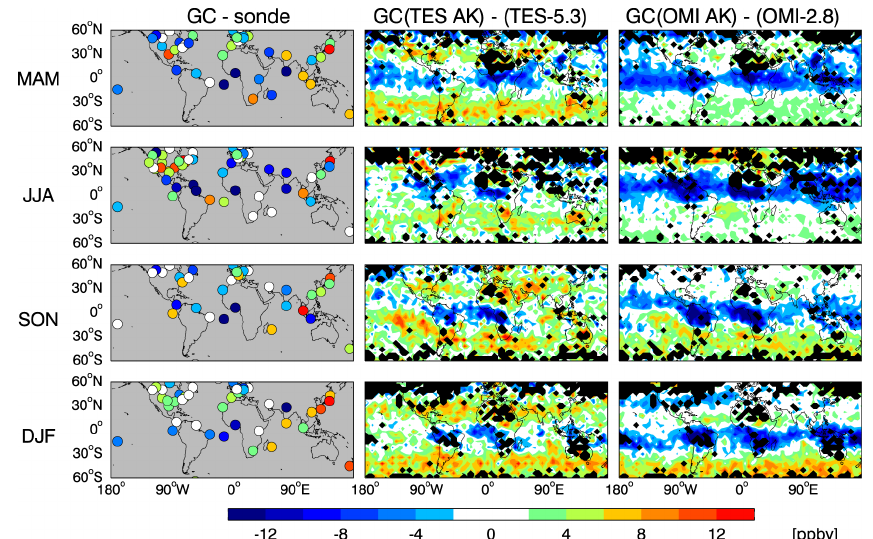
Fig. 8. Differences of simulated GEOS-Chem (GC) ozone concentrations (ppbv) at 500hPa with ozonesondes (left), TES (central), and OMI (right), averaged for the four seasons of 2006. Comparisons with TES and OMI use the GEOS-Chem profiles smoothed by the respective instrument averaging kernels as shown in Fig. 3. Satellite measurements have been corrected for the mean positive biases of 5.3ppbv for TES and 2.8ppbv for OMI. Red colors indicate that the model simulation is biased high and blue colors indicate that the model simulation is biased low. Black areas in the central and right columns indicate where differences between TES and OMI computed by the CTM method as shown in Fig. 7 are larger than 10ppbv or smaller than − 10ppbv, indicating that the satellite measurements are not